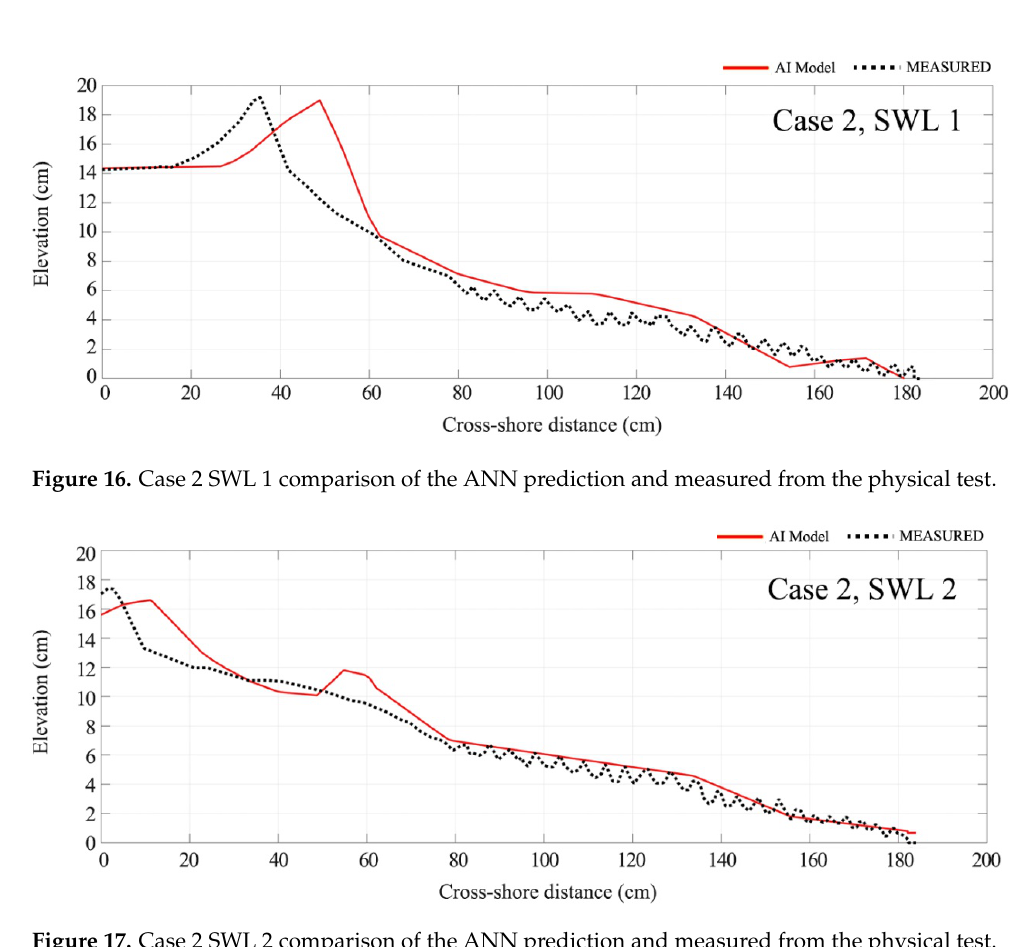
14 of 19 Figure 14. Case 1 SWL 1 comparison of the ANN prediction and measured from the physical test. Figure 15. Case 1 SWL 2 comparison of the ANN prediction and measured from the physical test. The typical gravel nourishment of Tuvalu was reproduced and tested using test case 2. Figures 16 and 17 show the results of the ANN model and compare the profiles. From